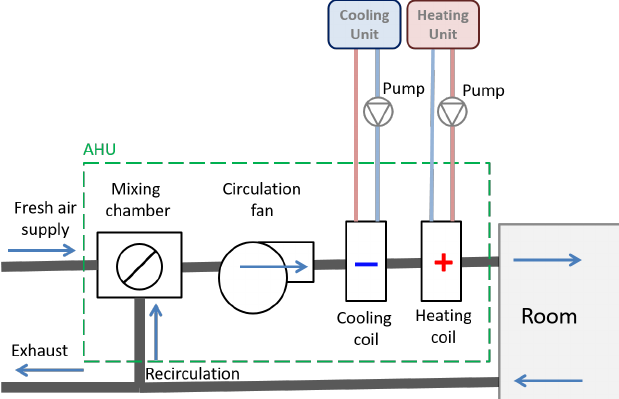
Figure 1: Air flow diagram through a typical fan coil compact HVAC